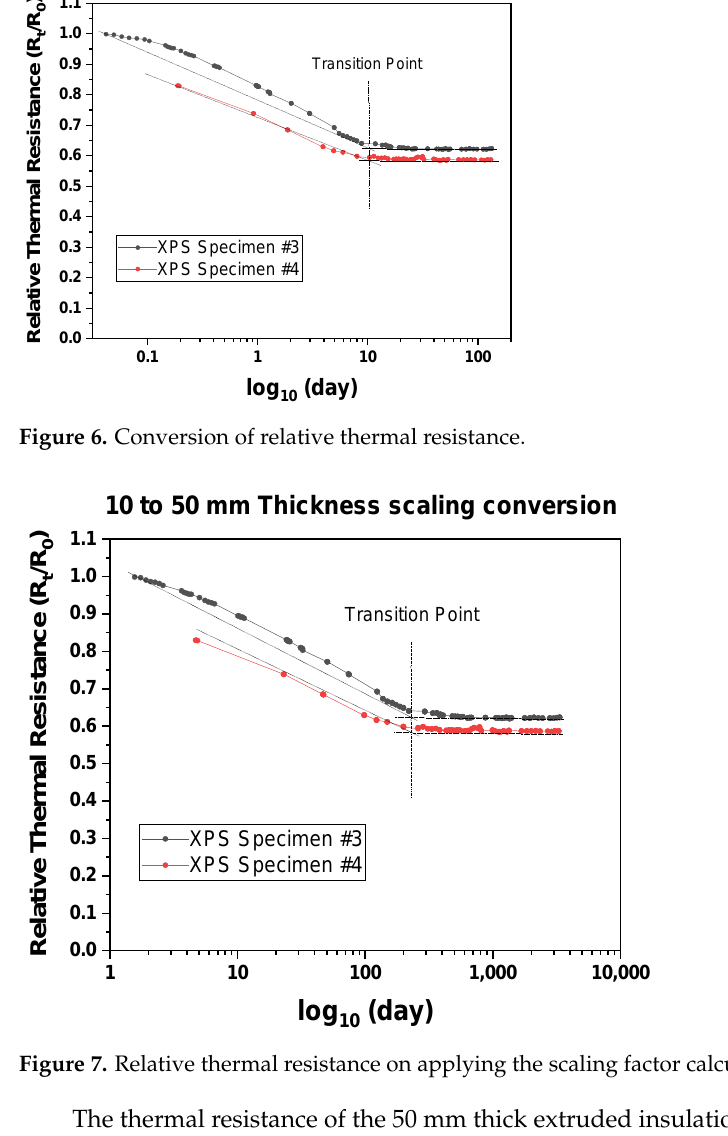
Figure 5. Acceleration test result.